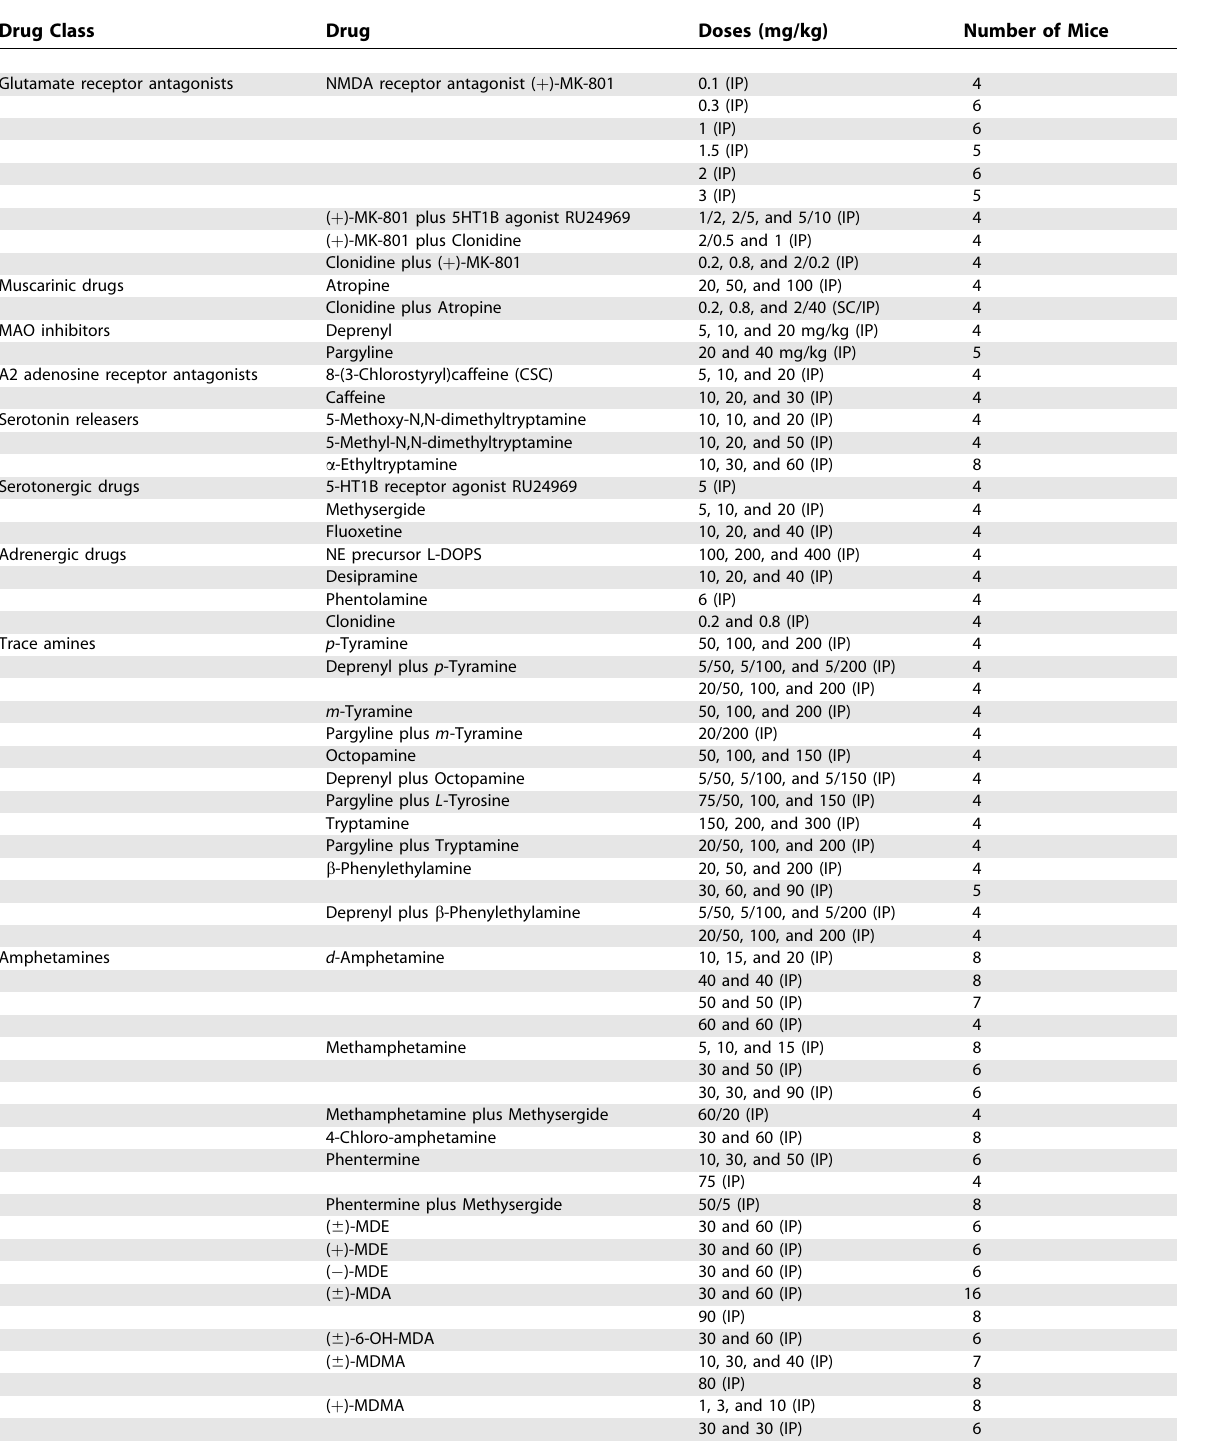
Table 1. Treatments That Were Not Effective in Restoring Forward Locomotion in DDD Mice Drug